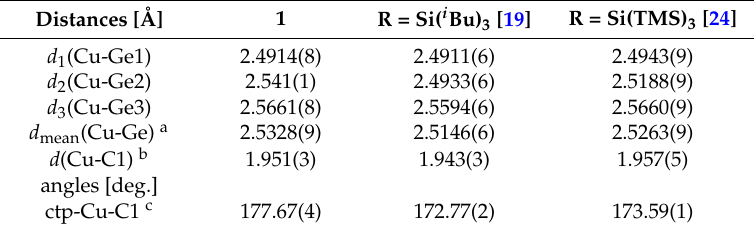
Table 1. Selected distances and angles in compound 1 and its analogues NHC Dipp Cu{ η 3 -Ge 9 R 3 } (R = Si( i Bu) 3 , Si(TMS) 3 ). Distances [Å] 1 R = Si( i Bu) 3 [19] R = Si(TMS) 3 [24] d 1 (Cu-Ge1)